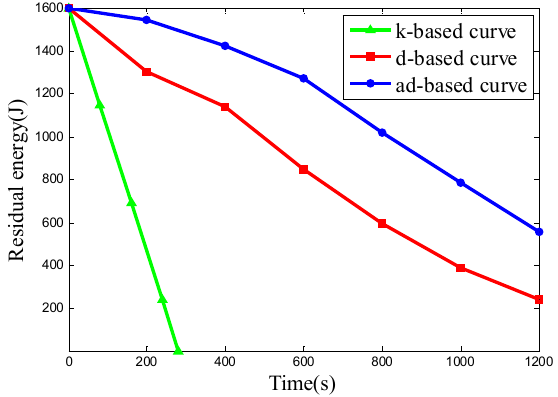
Figure 14. The residual energy of the network in Scenario 3.